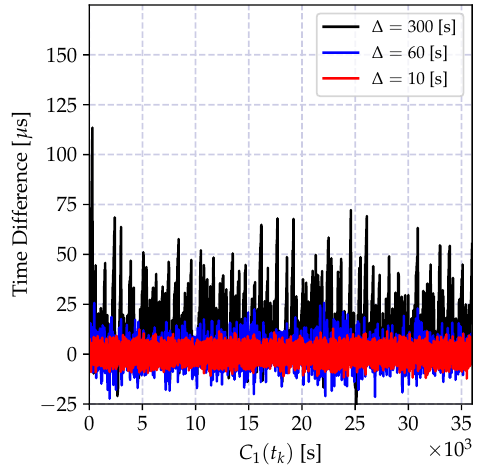
Figure 10. The time difference in microseconds between the time reports of a local clock and a reference clock when the time relation parameters of the progressive time model only with the message delivery delay are estimated at different periods ∆ using exponentially weighted recursive estimator in Equation (39a–c) with weight λ =